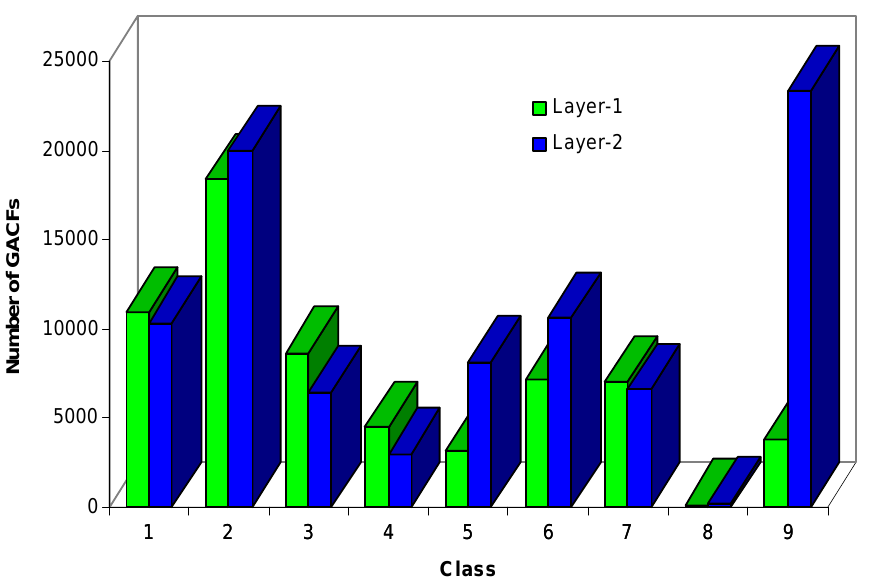
Figure 10. Comparison of the sizes of 1-GACF knowledge body and 2-GACF knowledge